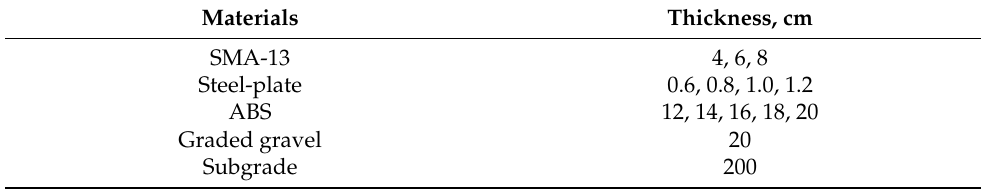
Table 4. The thickness of the ASP pavement structure.